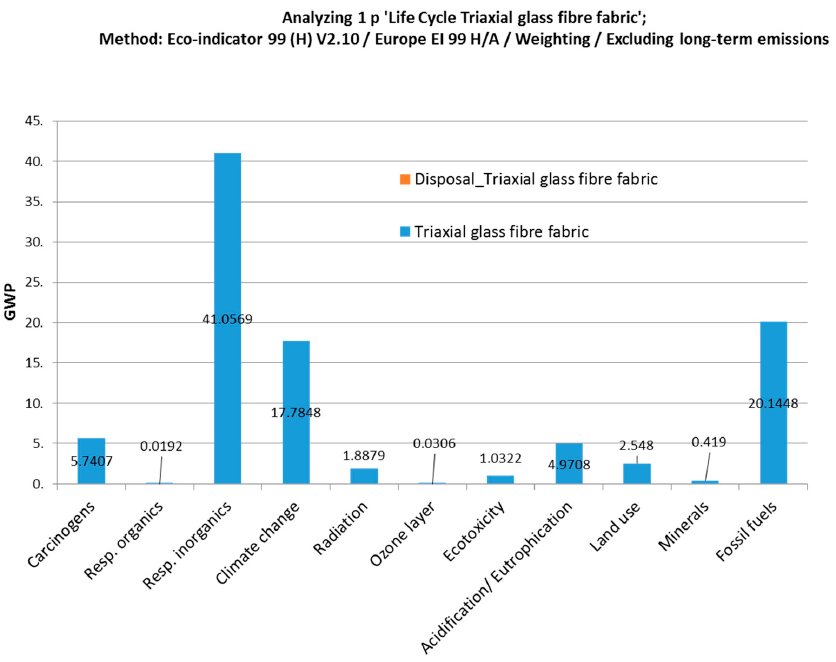
Figure 11. SimaPro 8: Environment impact of triaxial glass fibre fabric overall environment